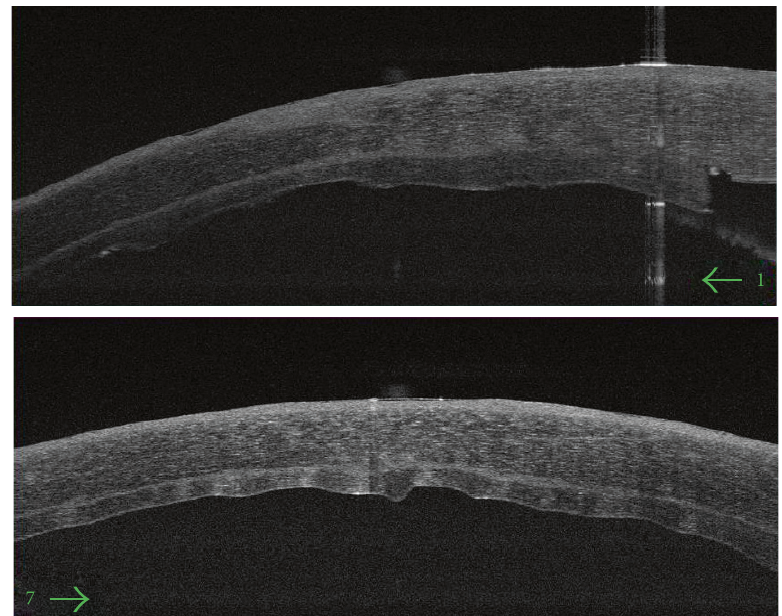
Figure 8: Complete reattachment after rebubbling for the second time.